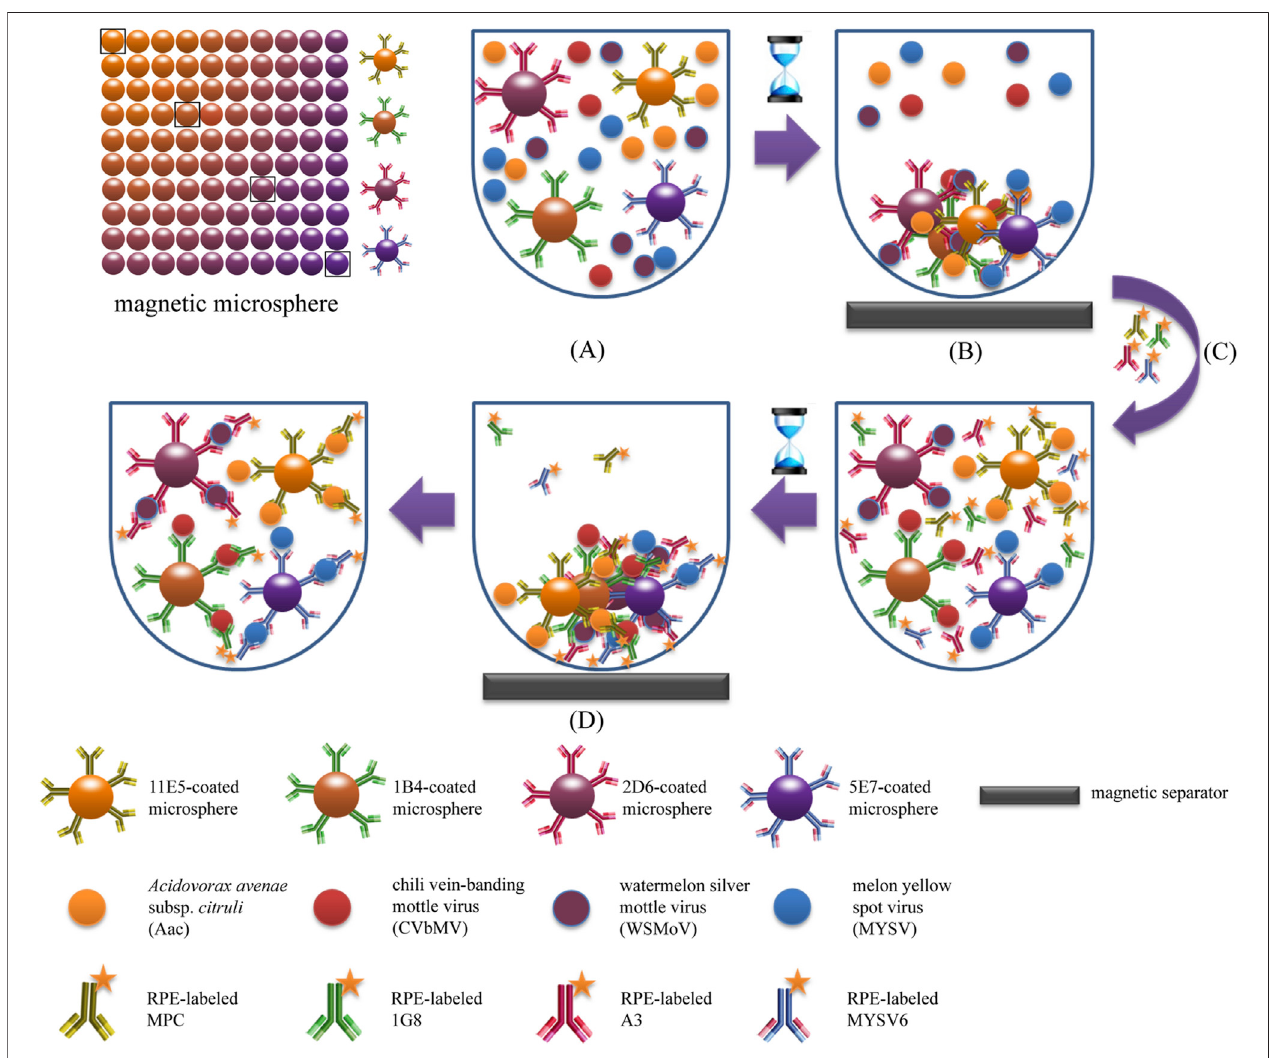
FIGURE 3 | Schematic illustration of magnetic microsphere immunoassay. Adapted with permission from Charlermroj et al. (Charlermroj et al., 2013).